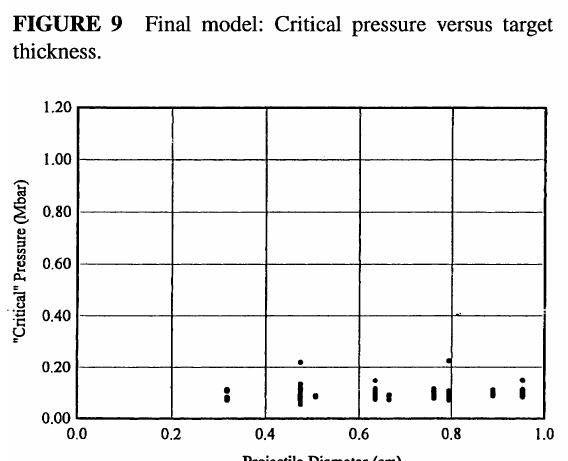
FIGURE 9 Final model: Critical pressure versus target thickness.